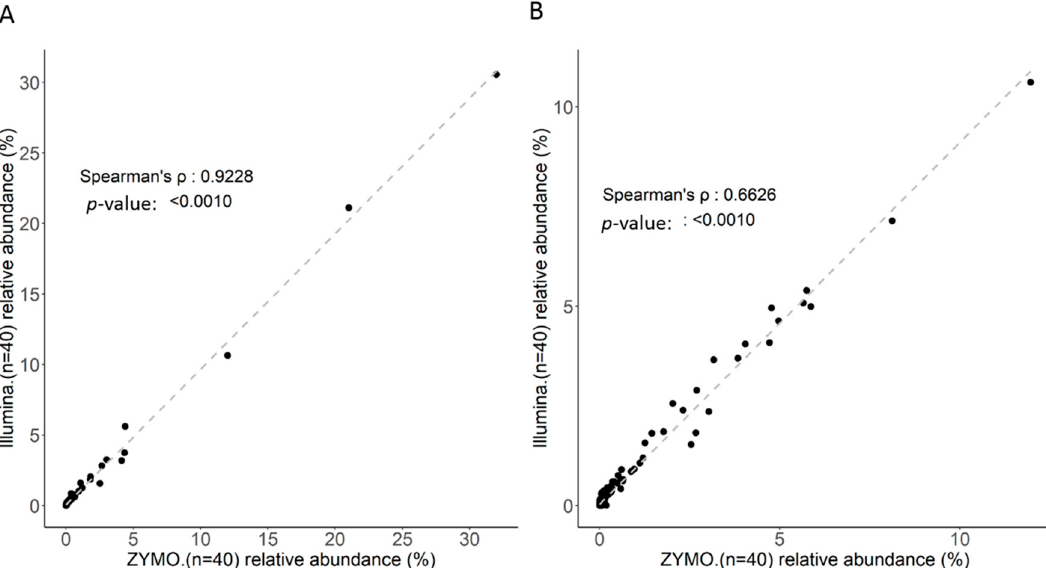
Figure 2. Correlation of identified taxa with two groups of MiSeq data using the Microbial module (CLC) coupled with the SILVA reference for all 44 samples at: ( A ) the genus level; and ( B ) the species level.